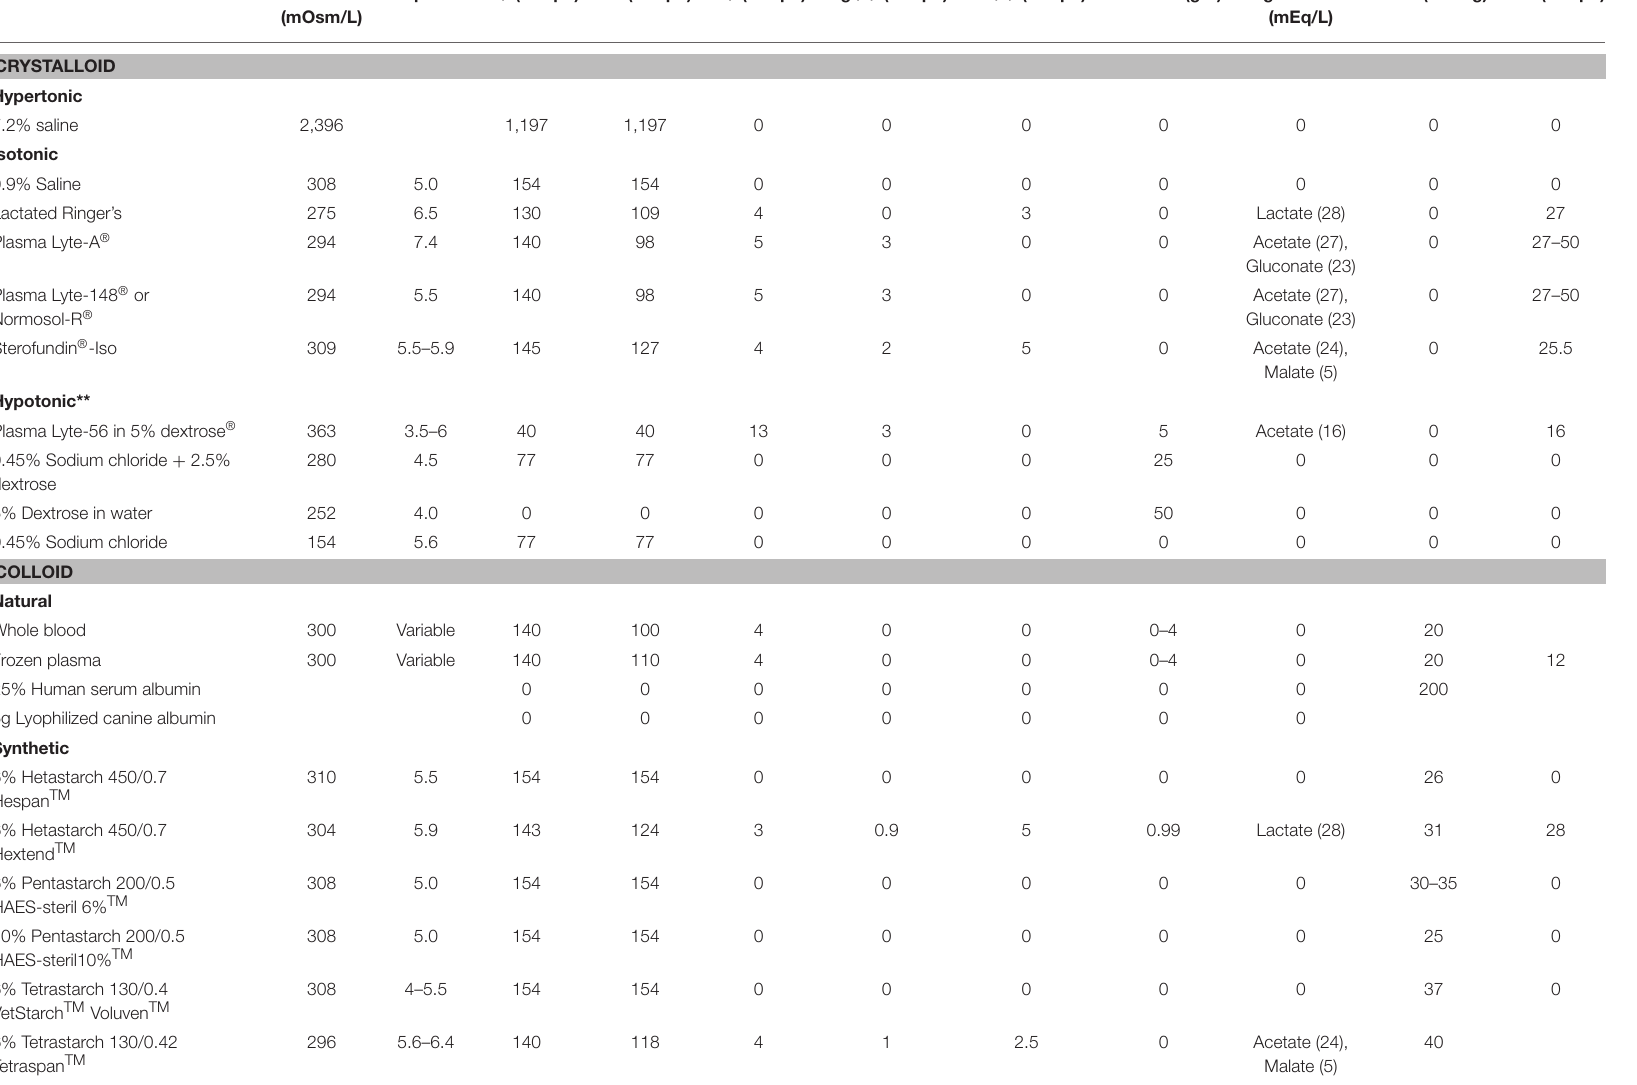
TABLE 1 | Characteristics of commonly used intravenous